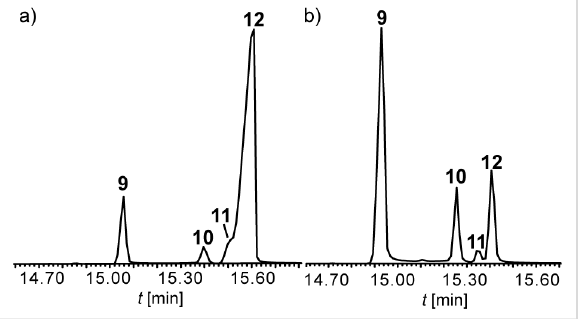
Figure 4: Total ion chromatograms of the product mixtures of isomers 9–12 synthesized under E -selective (a) and Z -selective Wittig reaction conditions (b).